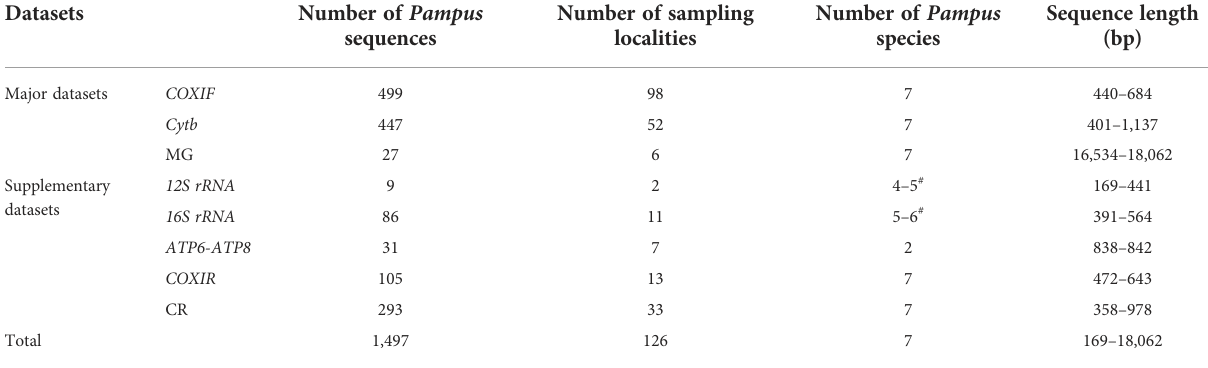
TABLE 1 Information from the eight datasets collated from 1,497 mitochondrial sequences of genus Pampus used in this study.